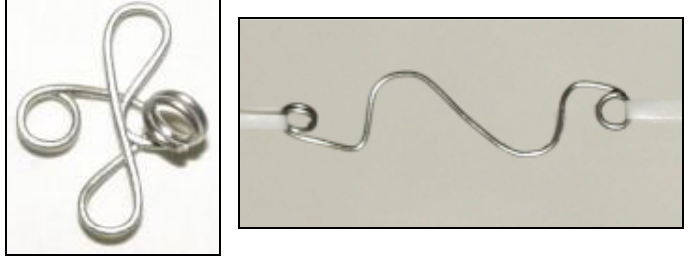
Figure 14: Wave spring in resting and activation